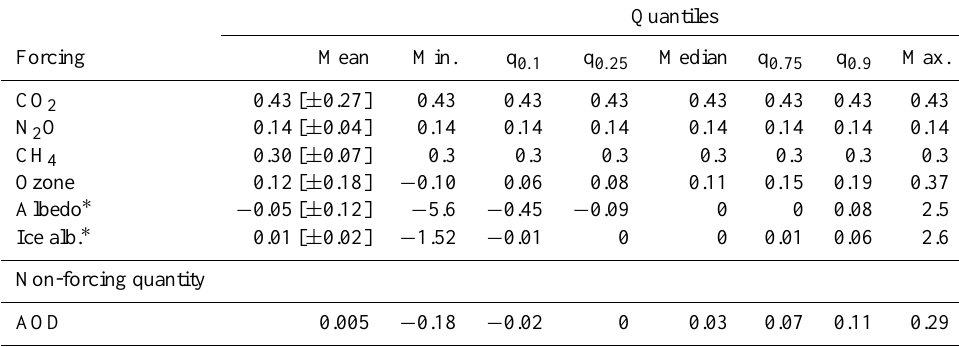
Table 4. Quantiles of the spatial distribution of the different forcings from historical LULCC (assessed in 2010) when represented as a probability density function. The grid spacing is 1.9 ◦ latitude by 2.5 ◦ longitude. Note that we show aerosol optical depth (AOD) in place of the aerosol forcings since the distribution of these forcings includes variability in cloud properties that are not directly attributable to changes in aerosols at this grid